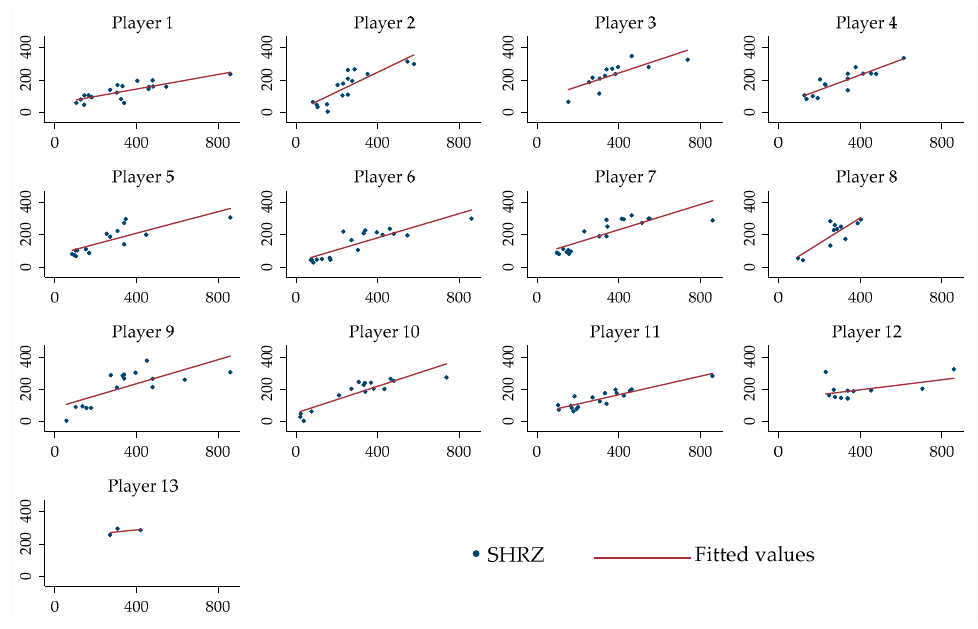
Figure 2. Relationship between the SHRZ (y axis) and sRPE for the individual players’ responses for all the sessions. Random intercepts and slope coefficients for each player based on the whole session LMM are reported in Table 3. Table 3. Random intercepts and random slope coefficients for each player based on the whole session Linear Mixed